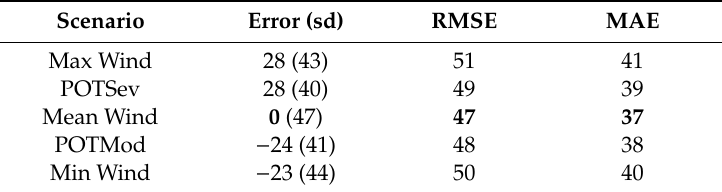
Table 8. Mean error, root mean square error (RMSE), and mean absolute error (MAE) of stand level mean crown scorch percent (calculated as the mean crown scorch length as a percent of pre-fire live crown length across all trees in a stand) by weather scenario, with errors closest to zero per error metric in